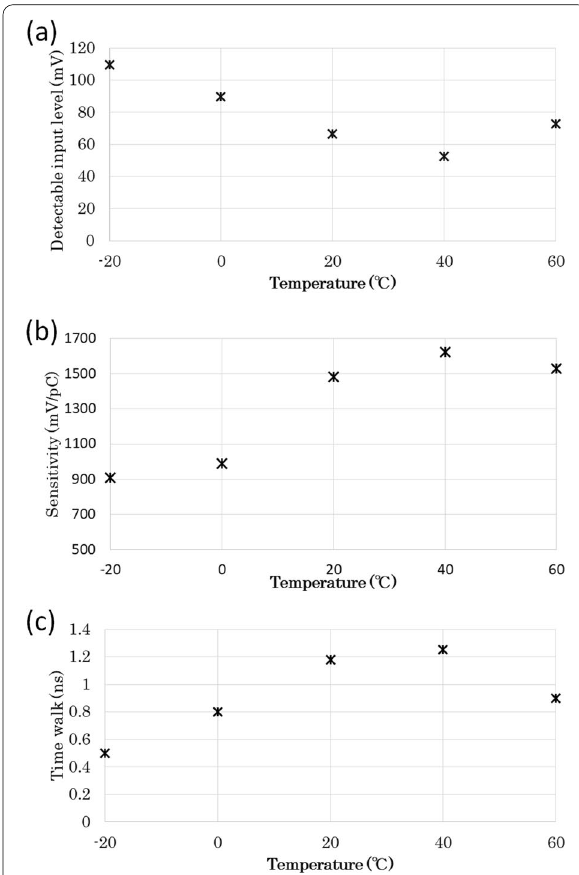
Fig. 10 Temperature dependence of the developed amplifier in terms of the detectable input level, sensitivity, and time walk. a The temperature dependence of the detectable input level, which is the lowest input pulse height that the comparator can detect. b The temperature dependence of the sensitivity (mV/pC). The values are the averages of the sensitivities obtained from two output waveforms in order of decreasing pulse height at each temperature from Fig. 9. c The temperature dependence of the time walk measured in